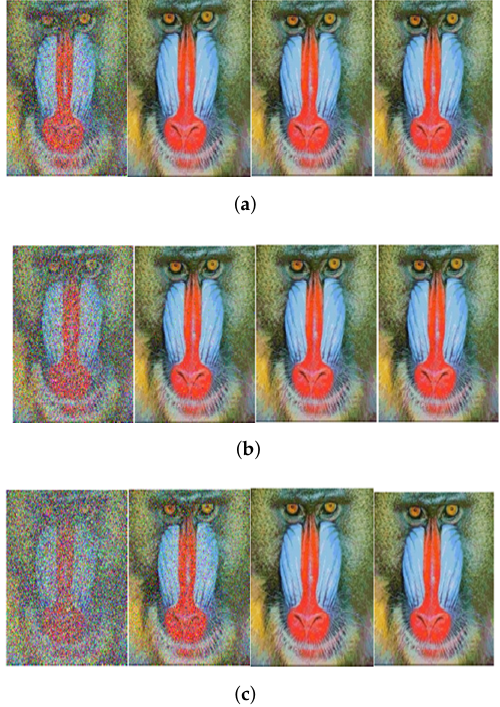
Figure 16. Received image with massive MIMO incorporated DWT-OFDM over a Rayleigh channel, Modulated with BPSK and at SNR = 0, 10, 20, 30 dB from Left to Right for different number of users, n . ( a ) n = 10; ( b ) n = 20; ( c ) n = 50.